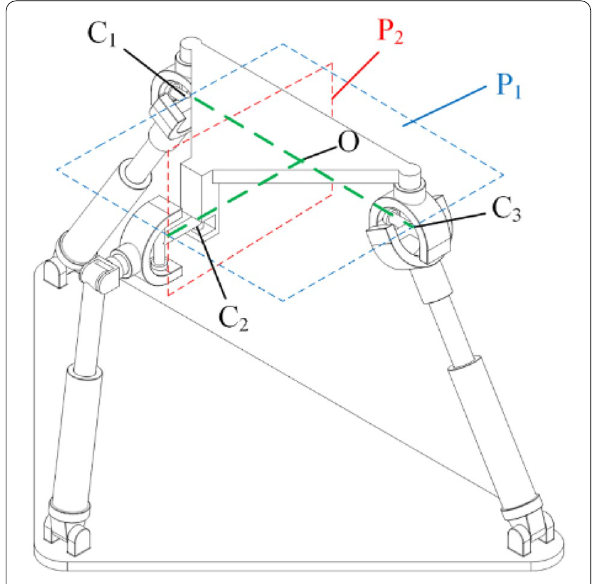
Figure 10 The schematic of rotation sequence